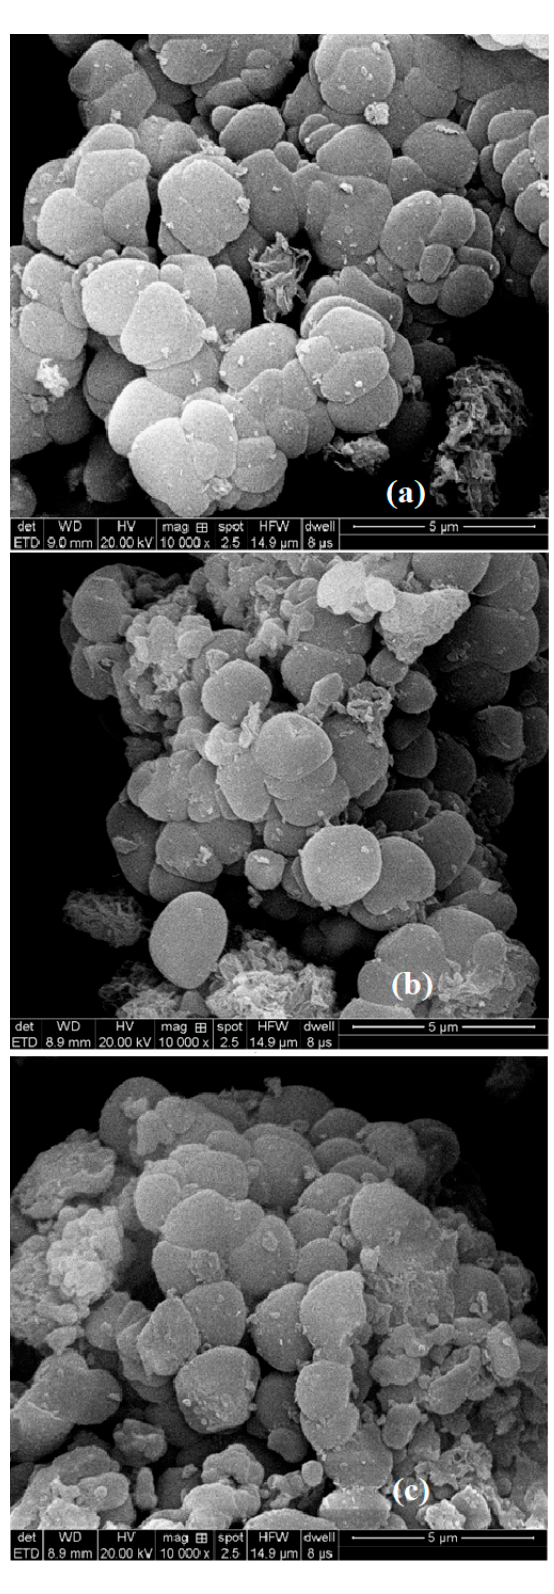
Figure 5. SEM micrographs of catalysts: ( a ) MCM-48, ( b ) Fe-MCM-48, and ( c ) cellulase-MCM-48.